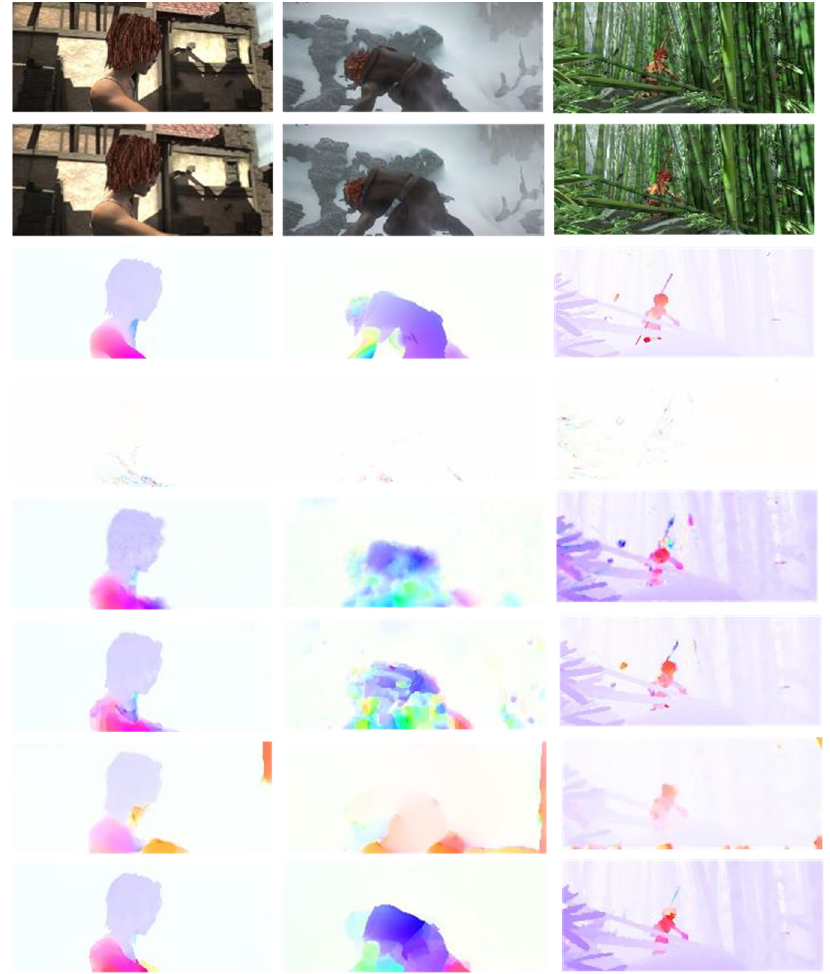
Figure 6. Comparison results of optical flow estimation in a single moving target scene. From left to right are the Alley2, Ambush4, and Bamboos2 datasets. The top-to-bottom areas show the current image, the next image, ground flow results, LK results, HS results, B&A results, Brox results, and this study’s results.